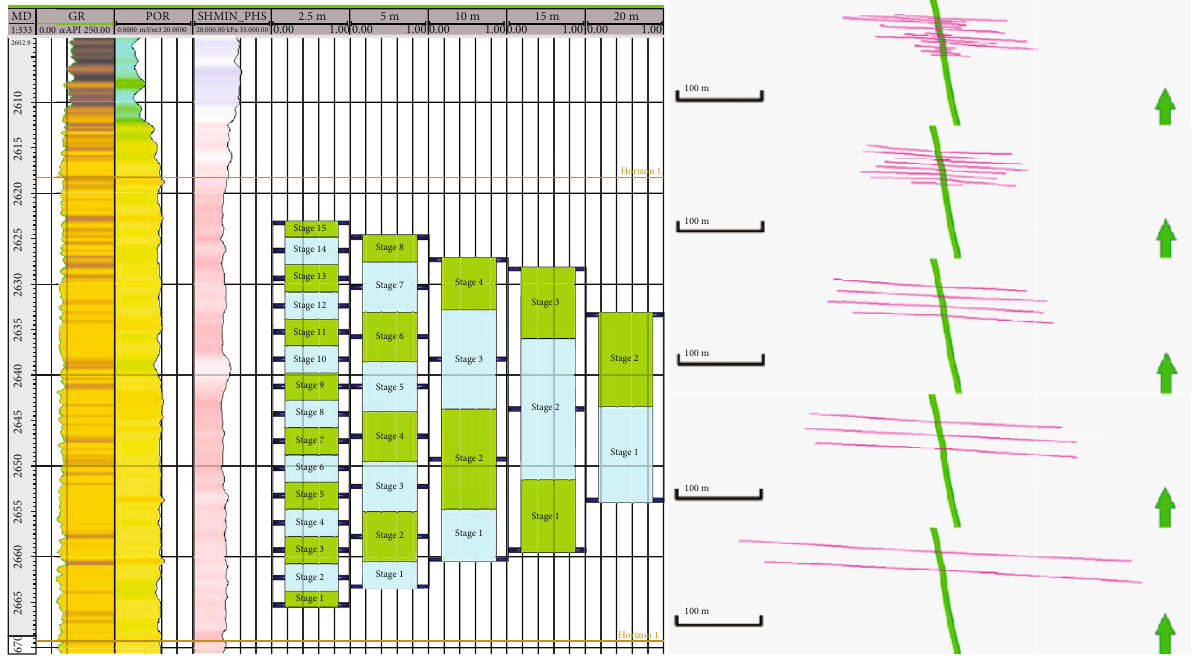
Figure 11: Locations of perforations and the fracture